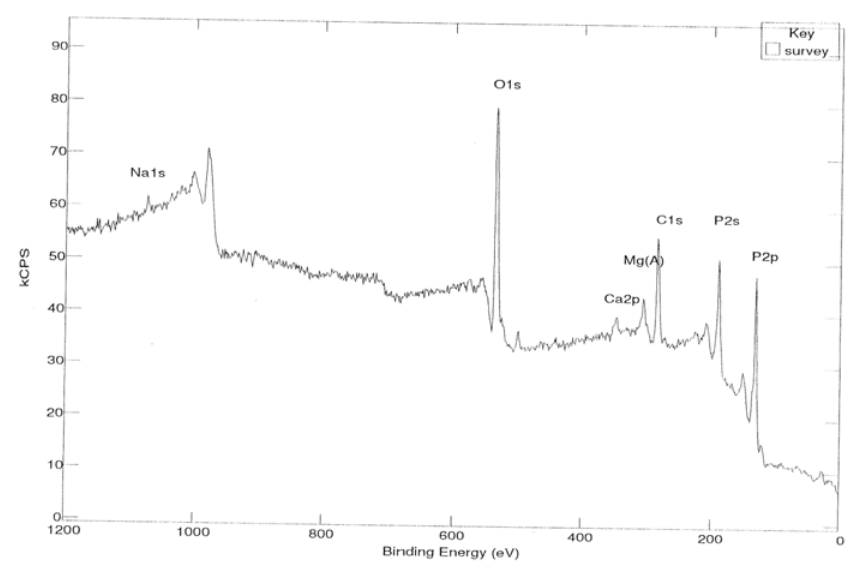
Figure 2 . XPS full scan spectra of P power (95%) by argon ion sputtering.